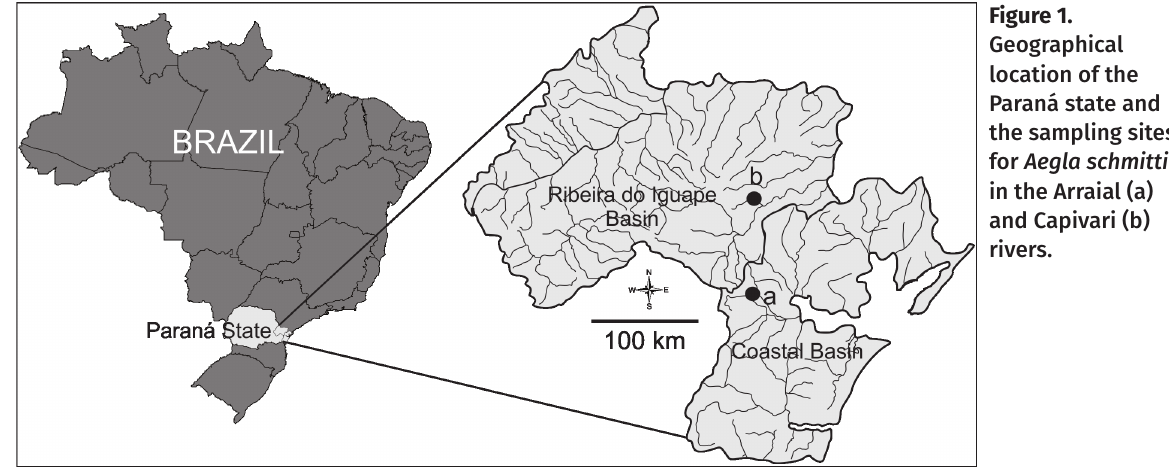
Figure 1. Geographical location of the Paraná state and the sampling sites for Aegla schmitti in the Arraial (a)